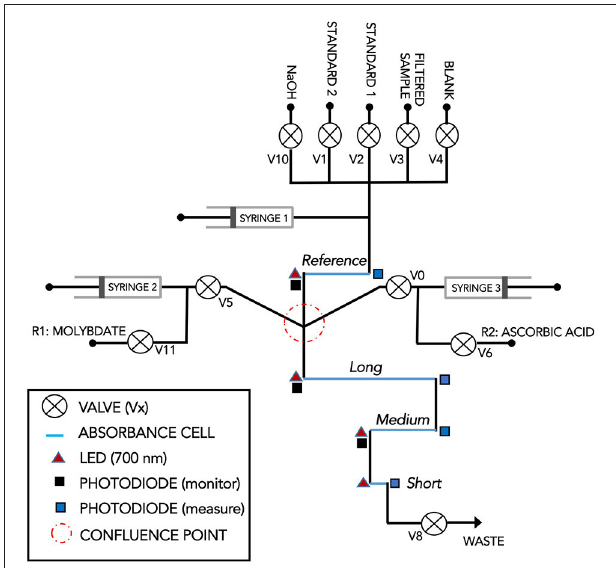
FIGURE 2 | Schematic flow diagram of Sensor 2. This sensor is the latest version designed and manufactured at the National Oceanography Centre Southampton. Absorbance cells: Long: 98 mm; Medium: 35 mm; Short: 2.5 mm. The reference cell (35 mm, but not used in this work) may be used to determine the absorbance of the sample prior to addition of the